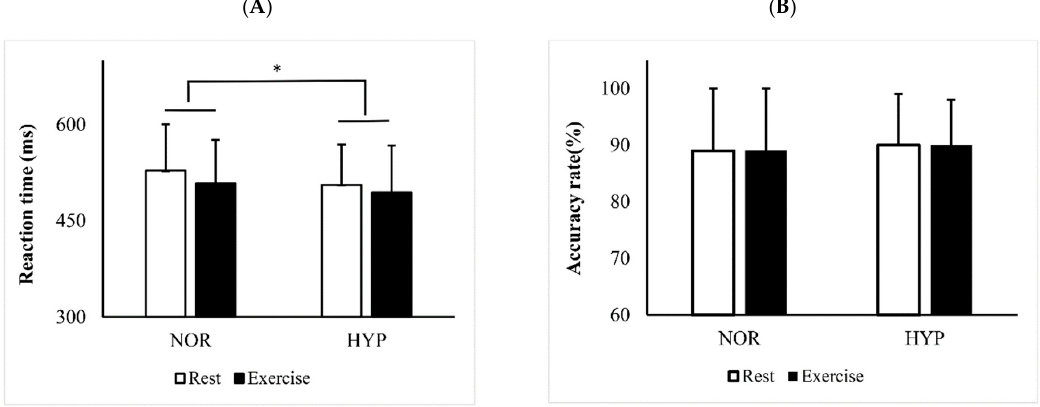
Figure 2. RT ( A ) and AC ( B ) in the interference control task under normoxia (NOR) and hypoxia (HYP). RT, reaction time; AC, accuracy rate. * p < 0.05 (NOR vs. HYP).